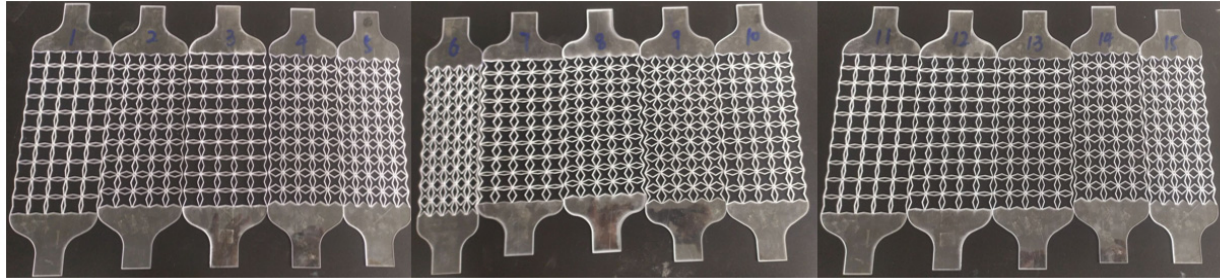
Figure 5. Four-pointed star honeycomb experimental specimen.